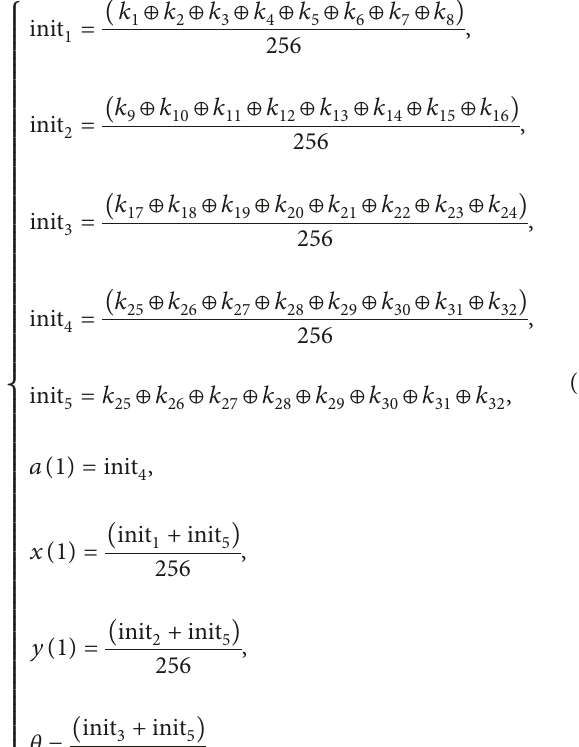
generated by the SHA-256 algorithm as the initial key. To calculate the initial values of the logistic map and the 2D- LSCM chaotic system, the hash sequence is divided into 32 equal-sized parts k , k , . . . , k . They are integers in the 1 2 32 interval [0, 255] when they are converted into decimal digits. Then, the initial values are obtained through for- mula (3). Pseudorandom sequences are calculated through chaotic systems.